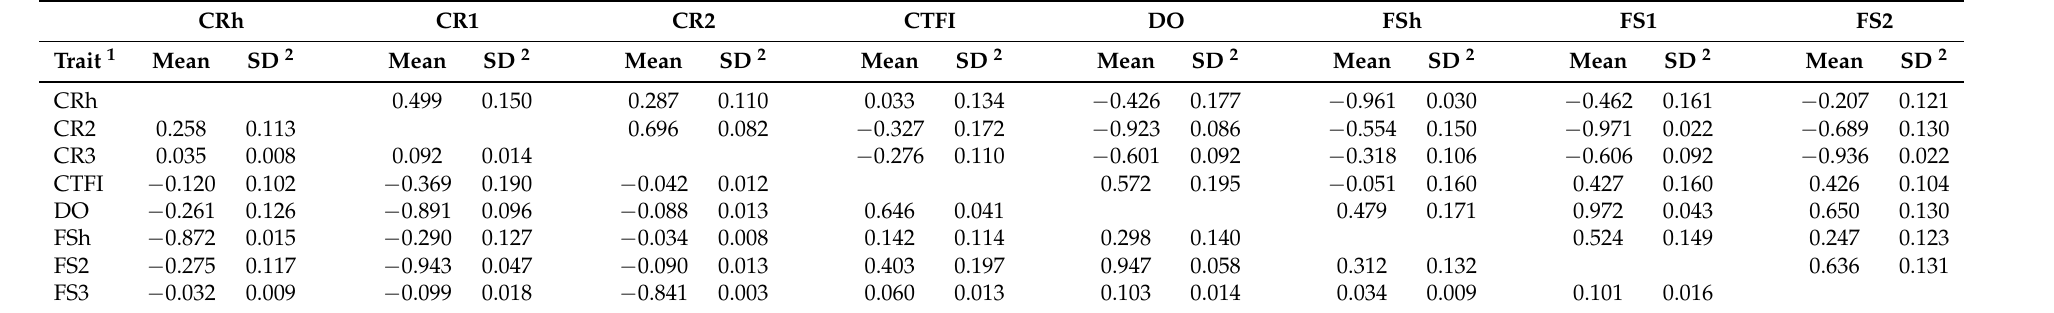
Table 4. Genetic (above diagonal) and phenotypic (below diagonal) correlations of fertility female